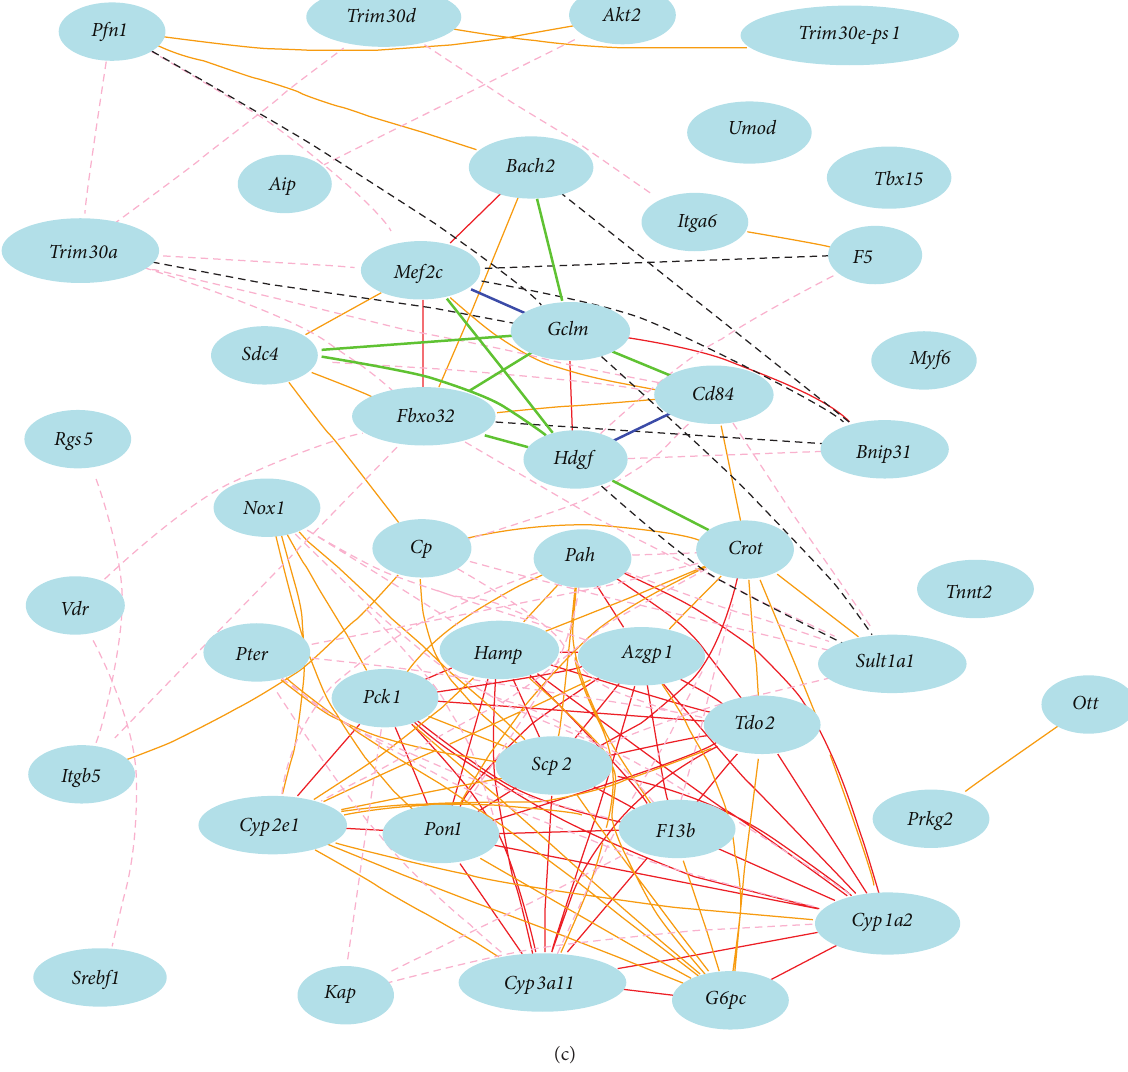
Figure 3: Gene network among bone relevant genes, which are upregulated in female while downregulated in male, constructed using expression profiles from spleen of male BXD mouse strains. (a) The 12 nodes in the graph below show the selected traits. All nodes are displayed. The 11 edges between the nodes, filtered from the 66 total edges and drawn as curves, show Pearson correlation coefficients greater than 0.35 or less than − 0.35. The graph’s canvas is 40.0 by 40.0 cm and the node labels are drawn with a 14.0 point font and the edge labels are drawn with a 14.0 point font. (b) The 32 nodes in the graph below show the selected traits. All nodes are displayed. The 117 edges between the nodes, filtered from the 496 total edges and drawn as curves, show Pearson correlation coefficients greater than 0.4 or less than − 0.4. The graph’s canvas is 40.0 by 40.0 cm and the node labels are drawn with a 14.0 point font and the edge labels are drawn with a 14.0 point font. (c) The 44 nodes in the graph below show the selected traits. All nodes are displayed. The 156 edges between the nodes, filtered from the 946 total edges and drawn as curves, show Pearson correlation coefficients greater than 0.4 or less than − 0.4. The graph’s canvas is 40.0 by 40.0 cm and the node labels are drawn with a 14.0 point font and the edge labels are drawn with a 10.0 point